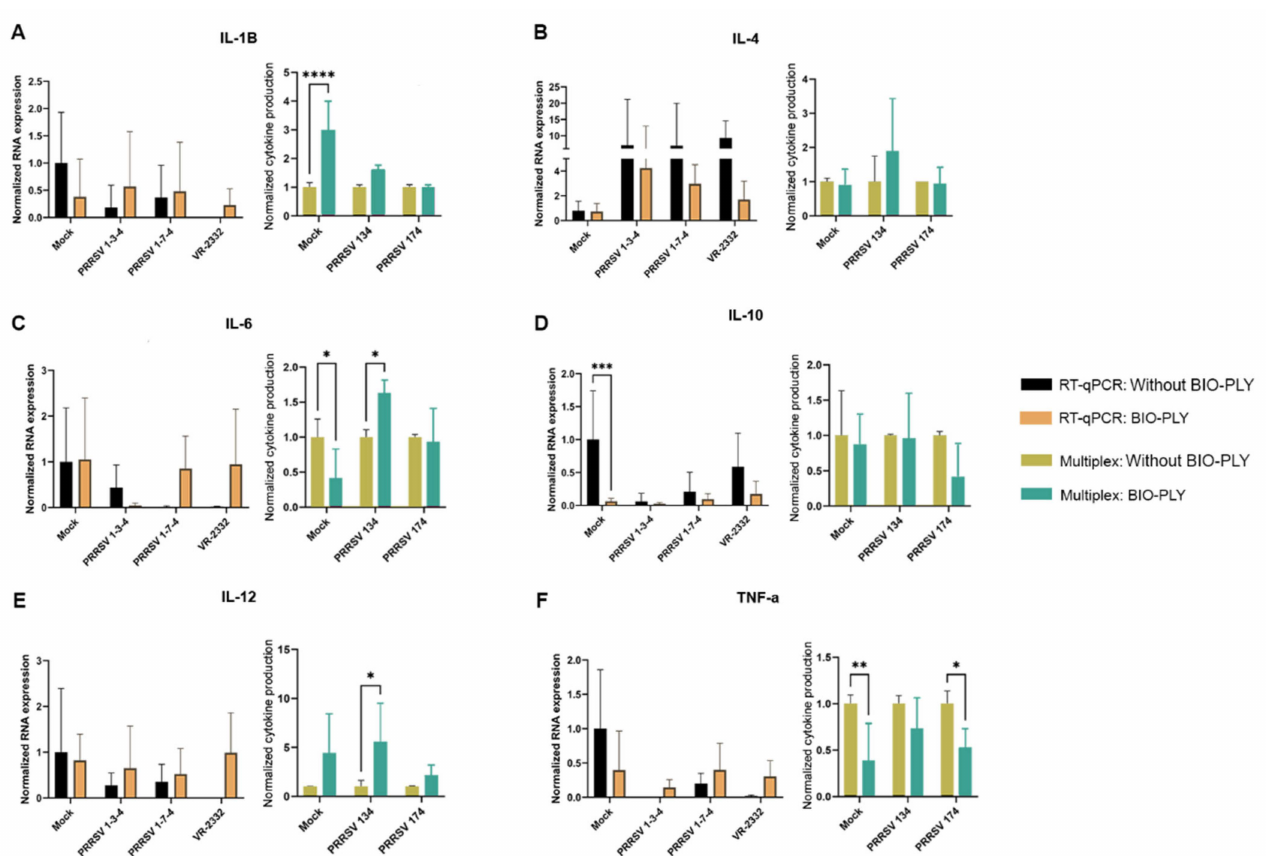
Figure 4. Effect of BIO-PLY TM on cytokines (mRNA or protein) in porcine alveolar macrophages (PAM) infected with PRRSV. Briefly, cells were infected with PRRSV for 24 h; after infection, cytokine expression was measured via RT-qPCR (shown in the left graph of each panel) and cytokine pro- duction in supernatants via multiplex (shown in the right graph of each panel). ( A ) IL1- β , ( B ) IL-4, ( C ) IL-6, ( D ) IL-10, ( E ) IL-12, ( F ) TNF- α . All experiments were performed using technical duplicates in biological replicates ranging from 3 to 5 pigs per experiment. Obtained values were normalized to the average of the mock values. Results were analyzed via two-way ANOVA and displayed showing means and standard error of mean (SEM). p -values were expressed using asterisks following APA and Prism standards. * p ≤ 0.05, ** p ≤ 0.01, *** p ≤ 0.001, **** p ≤